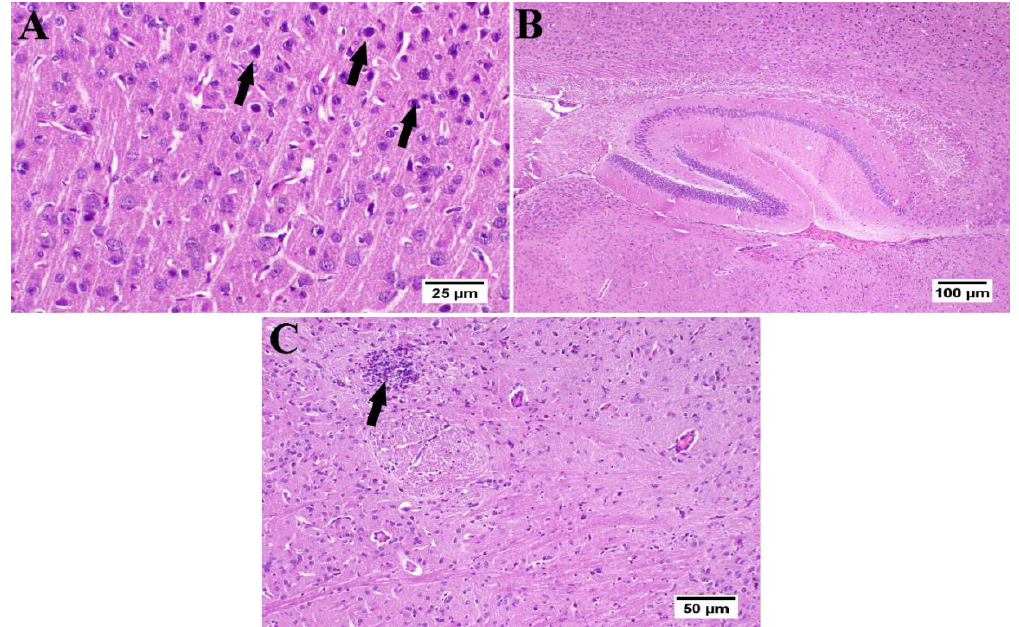
Figure 9. Effect of umuhengerin administration on mice brain histopathological alterations owing to STZ administration (group IV) (n = 3) (H&E). ( A ) The cerebral cortex showed few dark neurons (arrows). ( B ) The hippocampus showed apparently normal neurons in all examined regions. ( C ) The striatum revealed focal gliosis (arrow) and mild congestion.